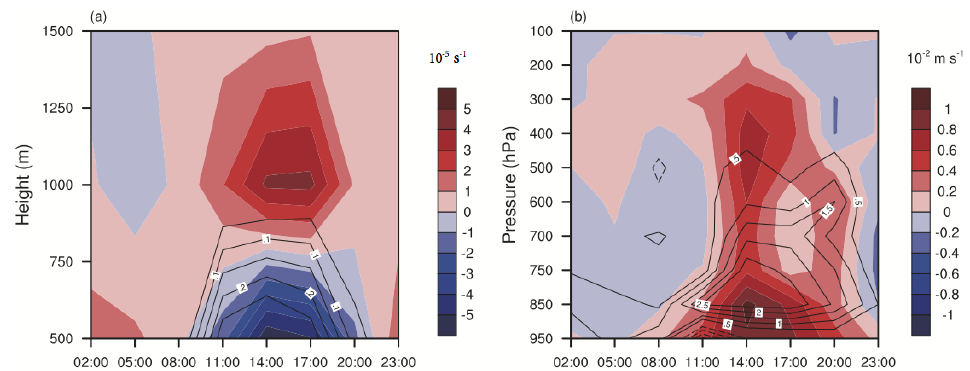
Figure 10. (a) Time–height cross sections of differences (between LU06E70 and LU70E70) in temperature (contour; units: ◦ C) and diver- gence (shade; units: 10 − 5 s − 1 ) averaged over the three city clusters (Nanjing, Shanghai, and Su-Xi-Chang); (b) same as (a) , but for vertical velocity (shade; units: 10 − 2 ms − 1 ) and cloud water mixing ratio (contour; 10 − 3 kgkg − 1 ) .